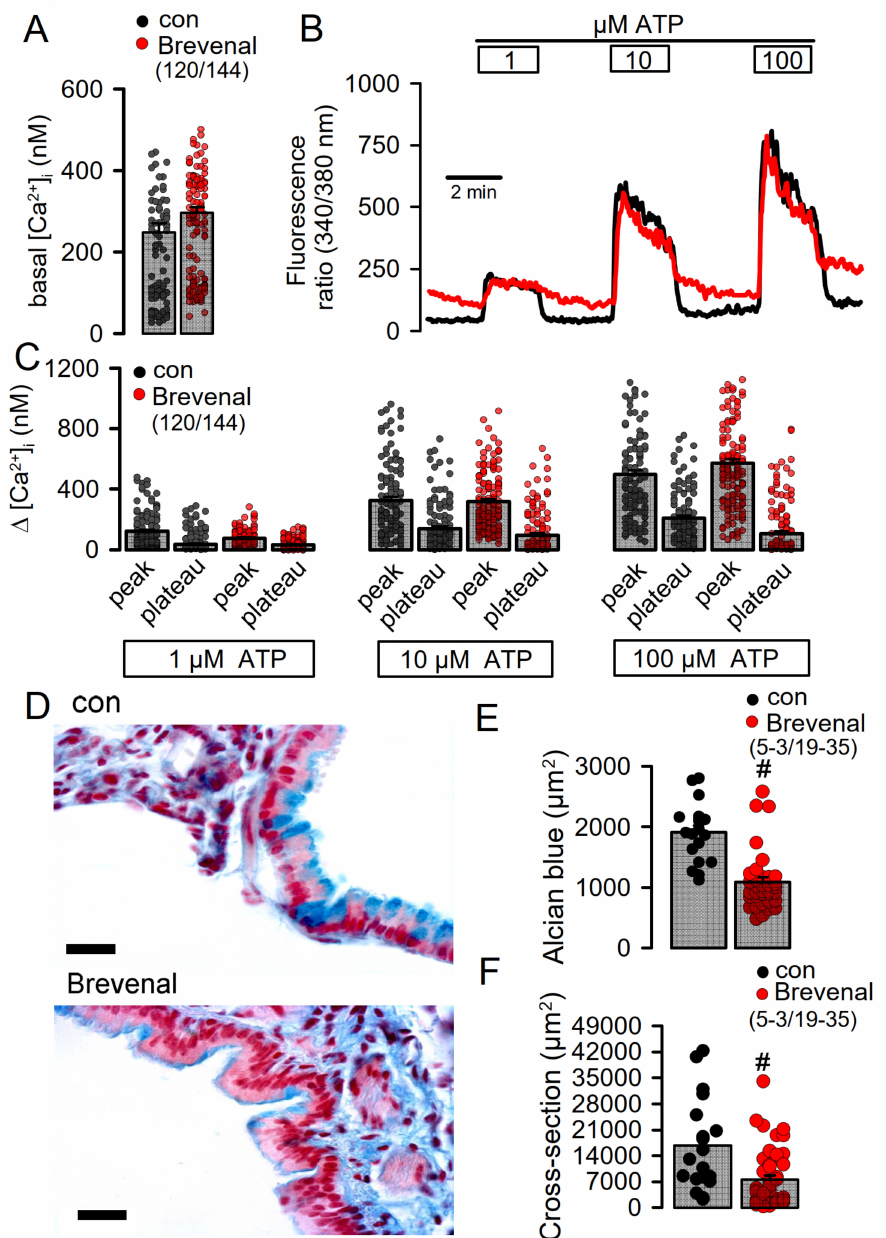
Figure 8. Brevenal does not increase intracellular Ca 2+ but releases mucus from goblet cells and induces airway contraction. ( A ) Comparable basal intracellular Ca 2+ levels in airway epithelial cells in the absence or presence of brevenal (500 nM, 15 min preincubation), as measured by the Ca 2+ sensor Fura-2. ( B ) Concentration-dependent rise in intracellular Ca 2+ by ATP in the absence or presence of brevenal. ( C ) Concentration-dependent increase in peak and plateau Ca 2+ by ATP in the absence or presence of brevenal. ( D ) Effects of acute application of brevenal (3.2 µ g/100 µ L, 10 min) in mouse airways by tracheal instillation. Alcian blue staining of mucus indicated reduced intracellular mucus in airways treated with brevenal. Brevenal-exposed airways appeared contracted. Bars = 15 µ m. ( E ) Summary of alcian blue staining in airway epithelial cells reflecting the amount of intracellular mucus, which is significantly reduced upon exposure to brevenal. ( F ) Summary of airway cross sectional area obtained in airways of control mice and mice treated with brevenal, suggesting airway contraction by brevenal. Mean ± SEM; (number of animals/number of measurements). # significant difference when compared to control mice ( p < 0.05,